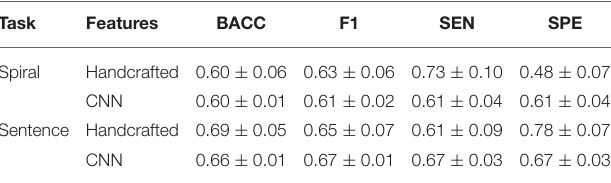
TABLE 6 | Classification performance in the scenario with all languages combined. Task